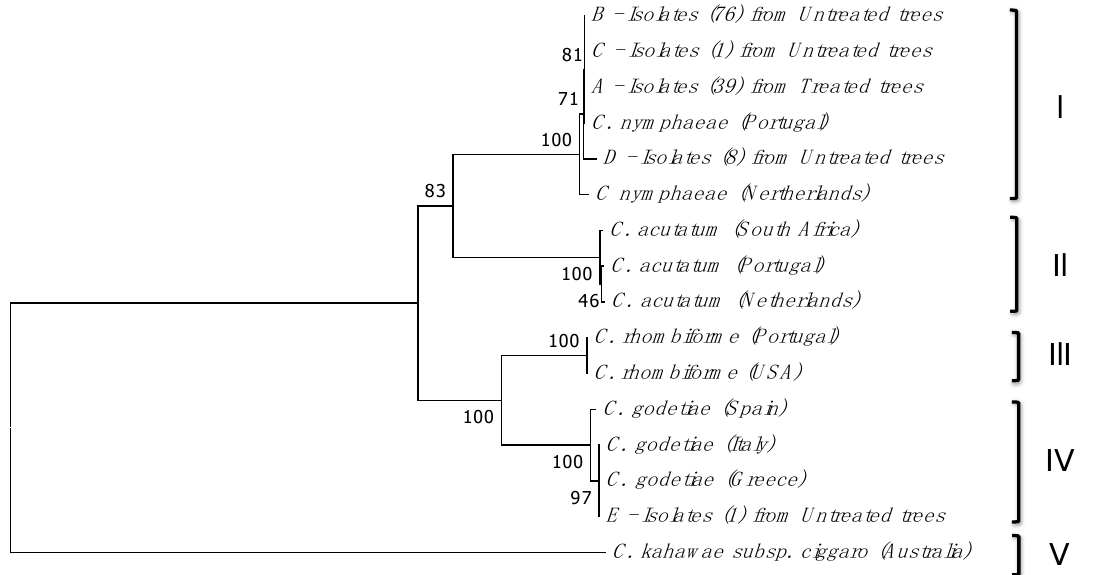
Figure 2. The NJ analysis was constructed from the sequence alignment of tub2, GAPDH, ACT, CHS-1 and HIS-3 (except for C. gloeosporioides complex) partial genes from isolates from C. acutatum complex ( C. nymphaeae , C. godetiae , C. acutatum and C. rhombiforme ) and C. gloeosporioides complex ( C. kahawae subsp. ciggaro ), using 125 isolates obtained in this study plus 11 sequences retrieved from the GenBank database, totalling 133 sequences. Repeated sequences within each group of isolates were omitted. Each sequence variant was named with a letter (A to E; except for A and B which are identical but differ in the management regime), following the number of isolates within each group.